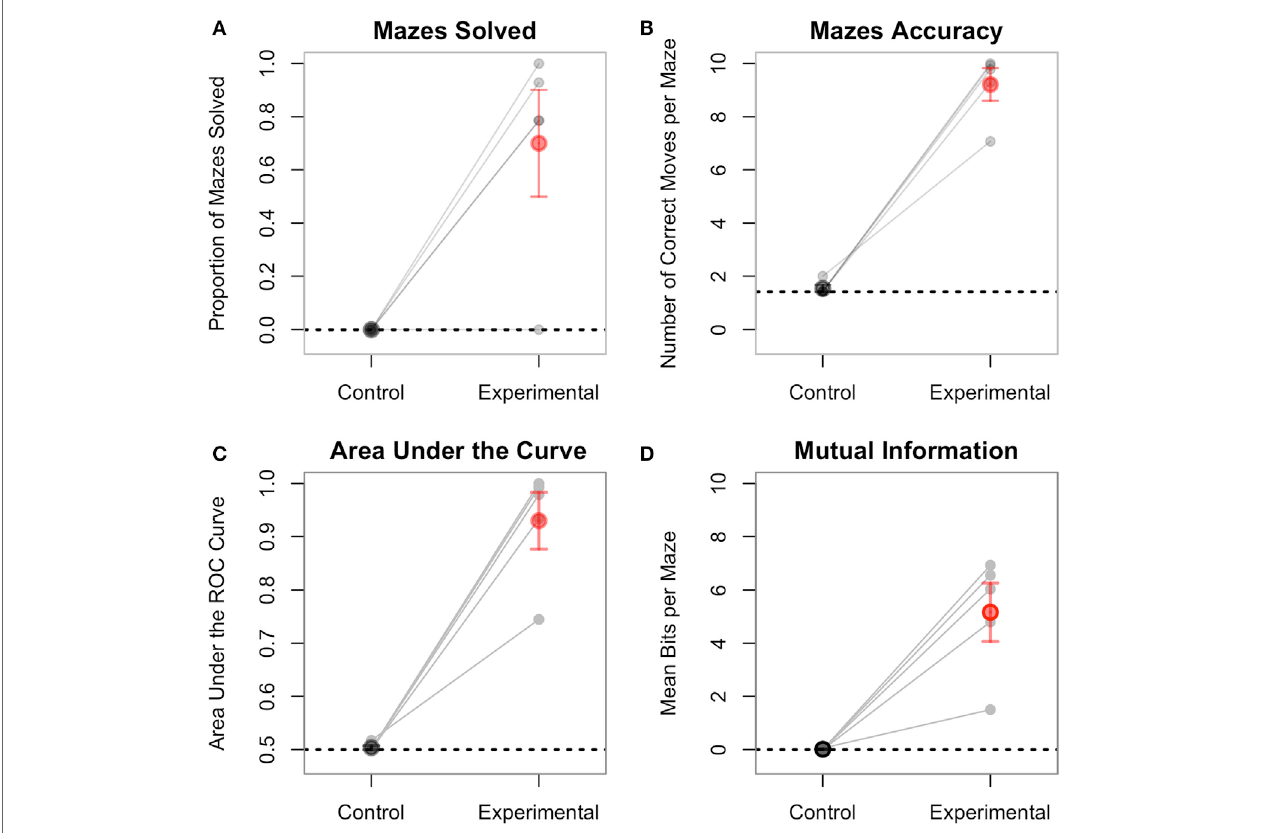
FigUre 7 | each line represents one subject, separately showing the experimental and control conditions . For all plots, the control condition is not statistically significant from baseline performance (dashed line). (a) The proportion of mazes solved (i.e., fully traversed) ranged from 0 to 100% in the experimental condition. In order to fully traverse a maze, subjects had to correctly classify all 10 consecutive pulses. (B) This figure shows the aggregate accuracy for the entirety of the experiment. One subject, despite not fully traversing any maze, still had an accuracy of over 70% for the experimental condition. (c) The AUC plot is the area under the curve of the ROC plots shown in Figure 8 . (D) Mutual information is a measure of the amount of information successfully transferred from the CBI to the